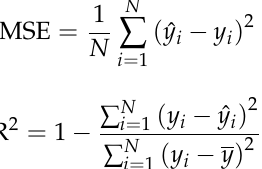
Figure 6. Comparison of the predicted and true values of the two models. The mean square error (MSE) and goodness of fit R 2 were used as an evaluation of the accuracy of the neural network modelling and were calculated as follows: